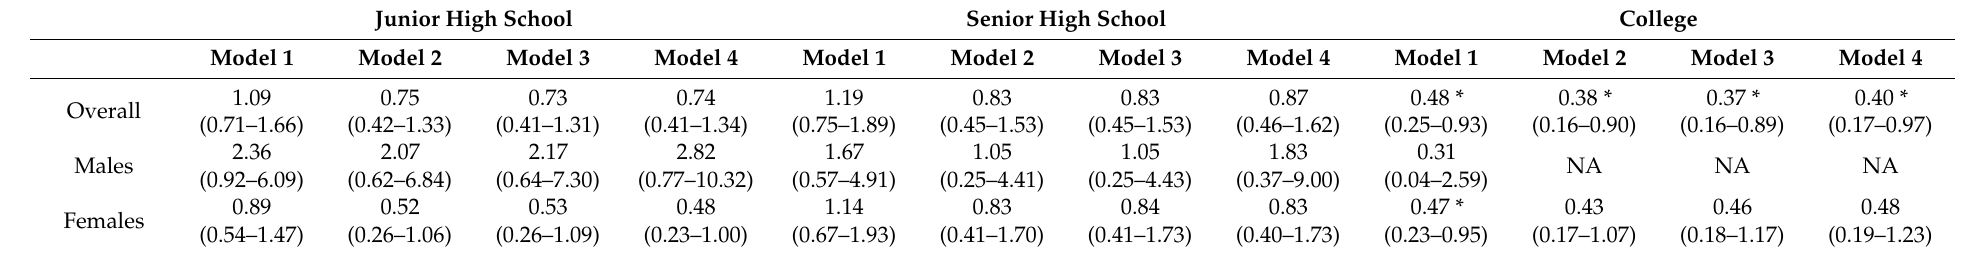
Table 4. Multinominal regression analysis on the association between gender contentedness and the first romantic relationship.